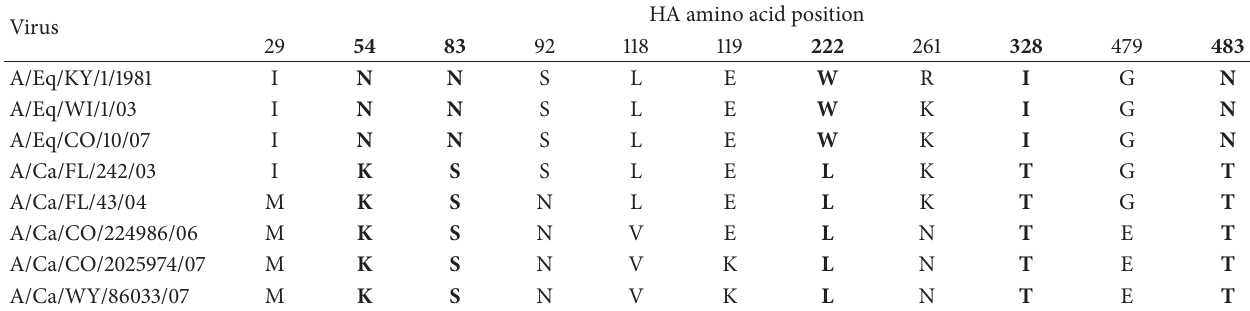
Figure 1: Phylogenetic comparison of canine and equine influenza virus H3 genes. Amino acid analysis was based on maximum parsimony with bootstrap analysis (values with > 50% consensus are shown). Challenge and receptor binding assay viruses are in parentheses. Table 1: Amino acid differences among the hemagglutinin protein of equine and canine influenza viruses. The five amino acids previously identified as EIV H3N8 mutations are in